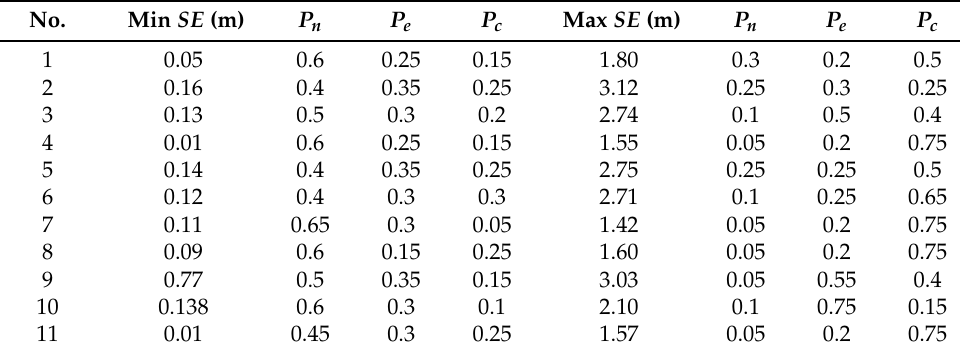
Figure 10. Different sets of probabilities affect MOTP of an experiment test. Table 2. Minimum and maximum of MOTP for each experiment.